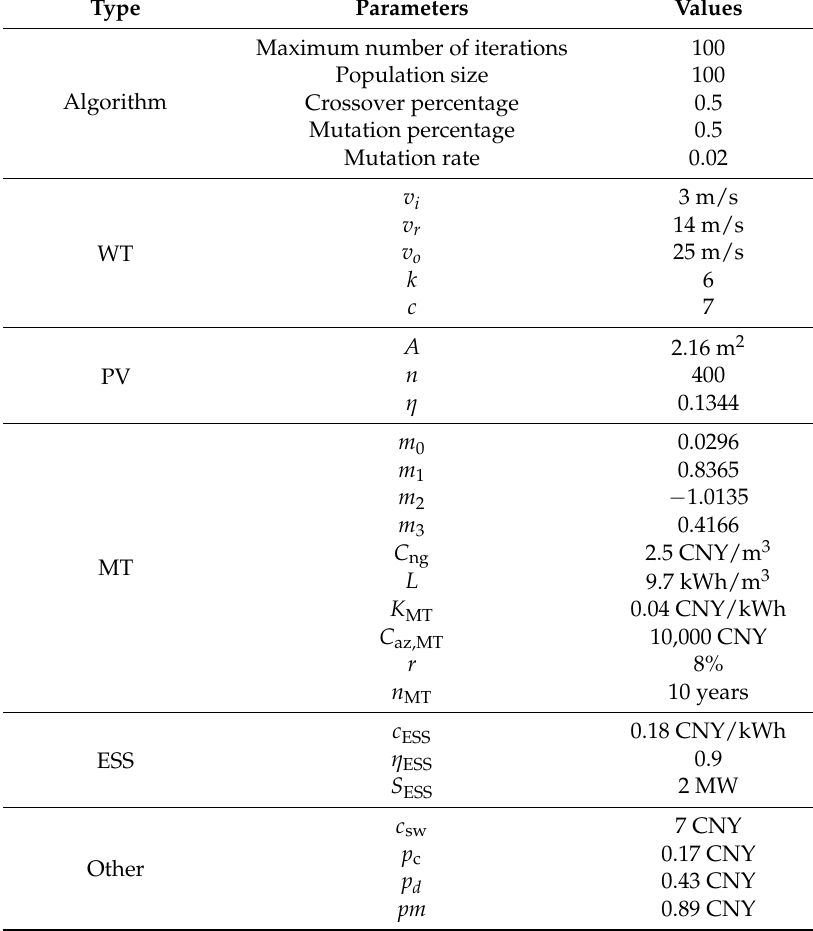
Table A1. Simulation